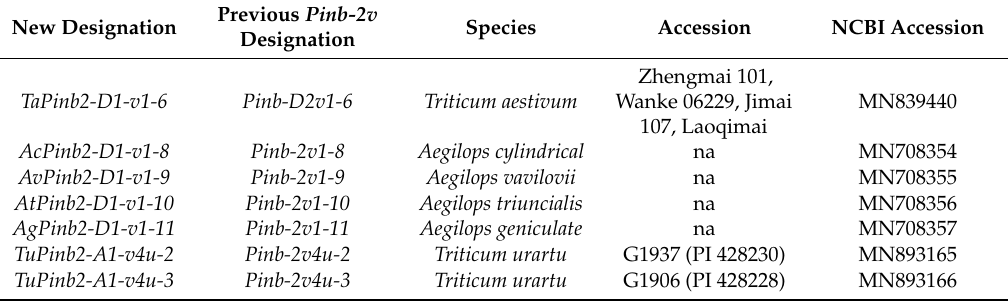
Table 3. The information of new Pinb2 alleles identified in this